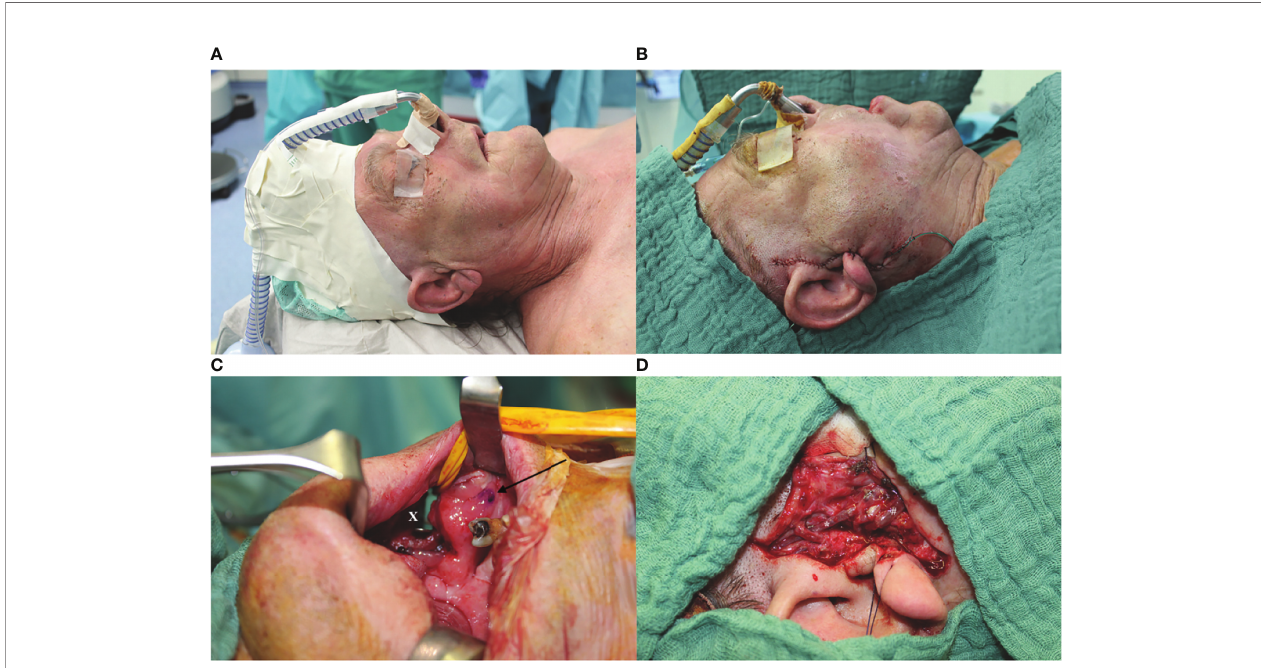
FIGURE 1 | Exemplary case demonstration with temporally anastomosed one-segmented osteomyocutaneous fi bula free fl ap because of osteoradionecrosis of the right mandibular body. Preoperative CT angiography revealed no reasonable cervical external carotid branches for microvascular anastomosis due to previous operations: (A) preoperative situation; (B) postoperative situation without cervical scars after mandibular reconstruction; (C) preparation of the transfacial subcutaneous tunnel (x) with careful preservation of the parotid duct, its intraoral ostium (arrow), and the accompanying buccal branch of the facial nerve; and (D) temporal anastomoses with the super fi cial temporal artery and vein (STA/V). The STV has been divided to allow the anastomoses of two veins, one draining retrograde to the super fi cial scalp (*) and the other orthograde into the deep cervical venous system